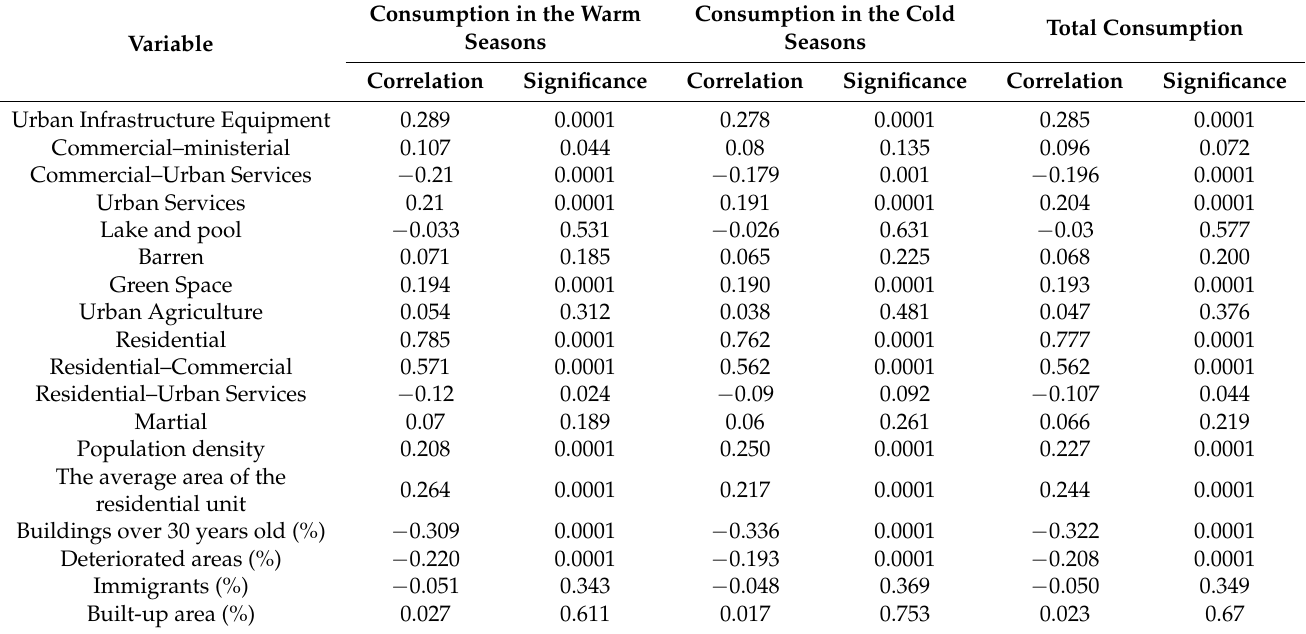
Table 5. Correlation and significance of factors with water consumption (the warm season, the cold season and